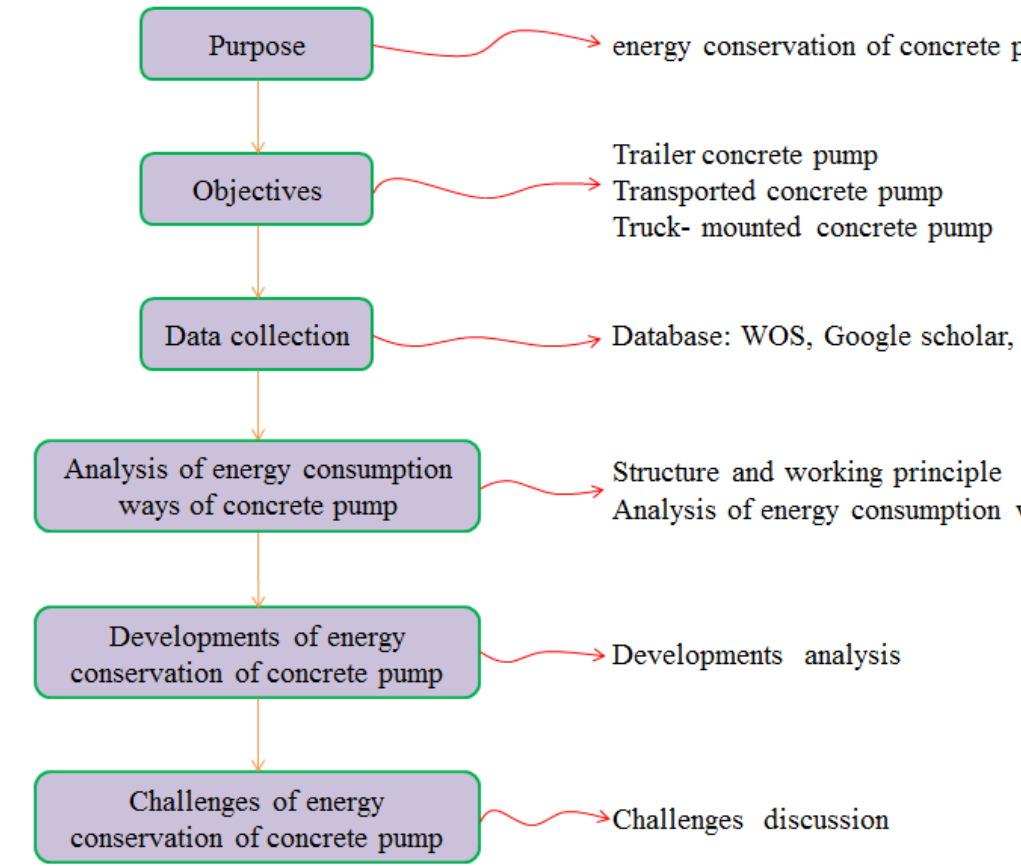
Figure 1. The basic research process.